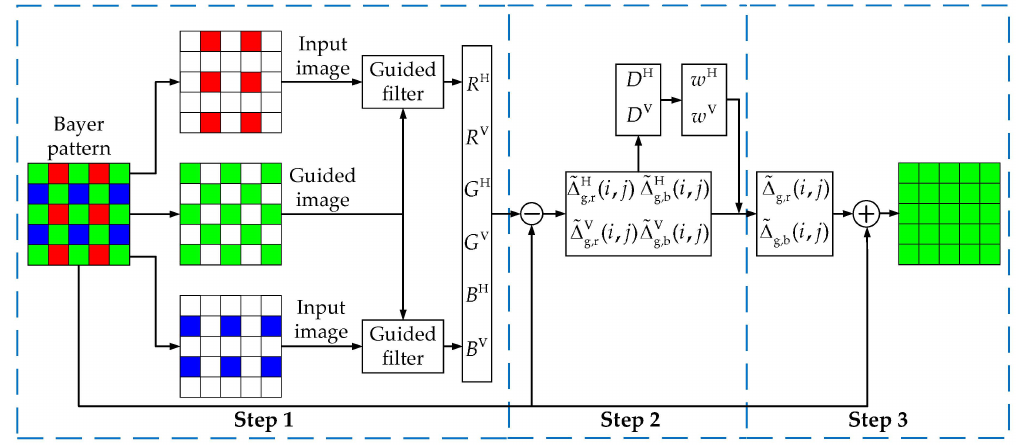
Figure 3. The outline of the proposed algorithm.